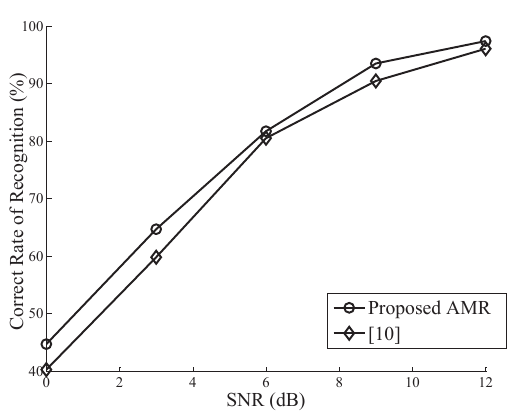
Figure 3. Performance versus SNR for Ω 1 . AMR: automatic modulation recognition.